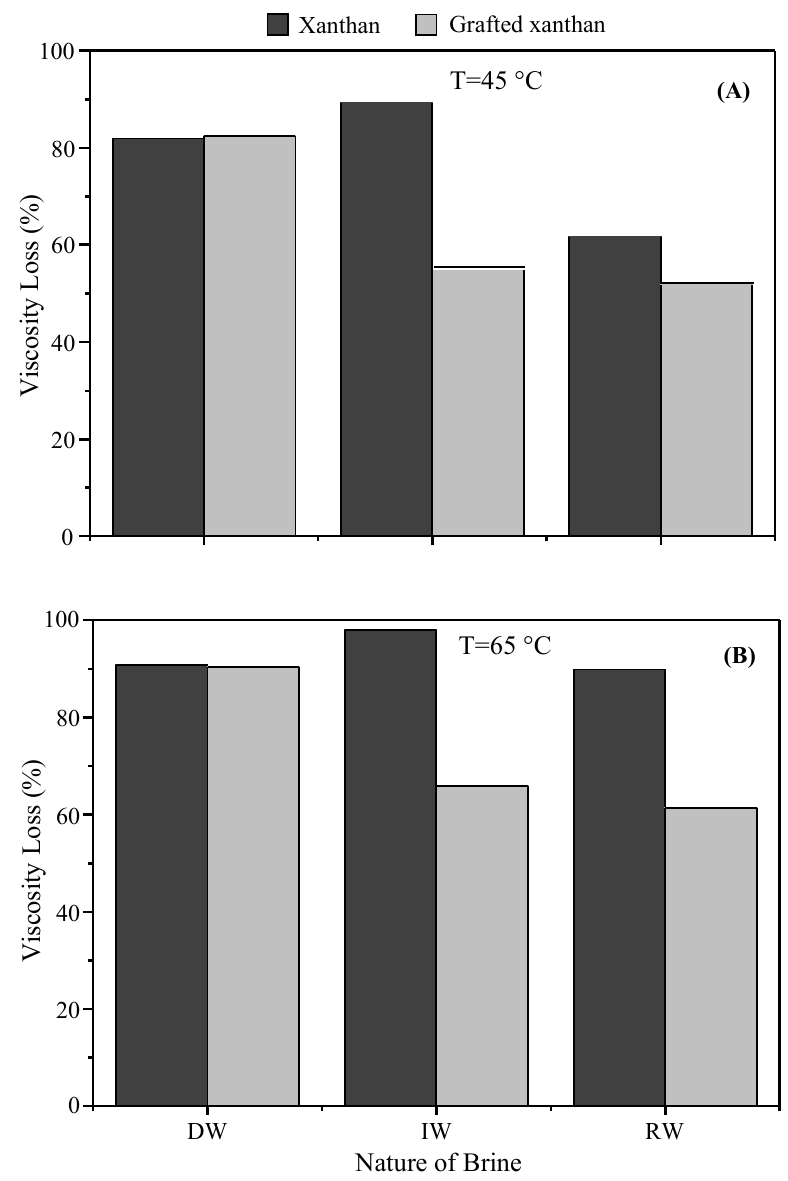
Nature of Brine Figure 7. Viscosity loss ratio at 45 °C ( A ) and 65 °C ( B ) of polymer solutions. As seen for solutions in deionized water, the viscosity losses due to temperature are extremely high and the same losses are observed for both polymers. Thus, the polymer solutions retain about 18% of their initial viscosity when the temperature is raised to 45 °C. At around reservoir temperature (65 °C), viscosity loss reaches more than 90%. For solutions in injection water the degradation due to temperature is more critical for